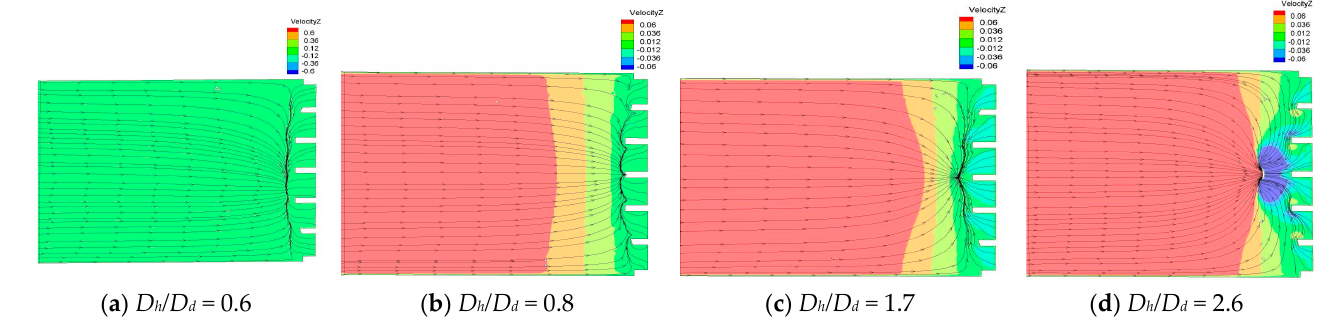
Figure 12. Suction sump flow line and axial flow velocity distribution (section 2 - 3, unit: m/s).